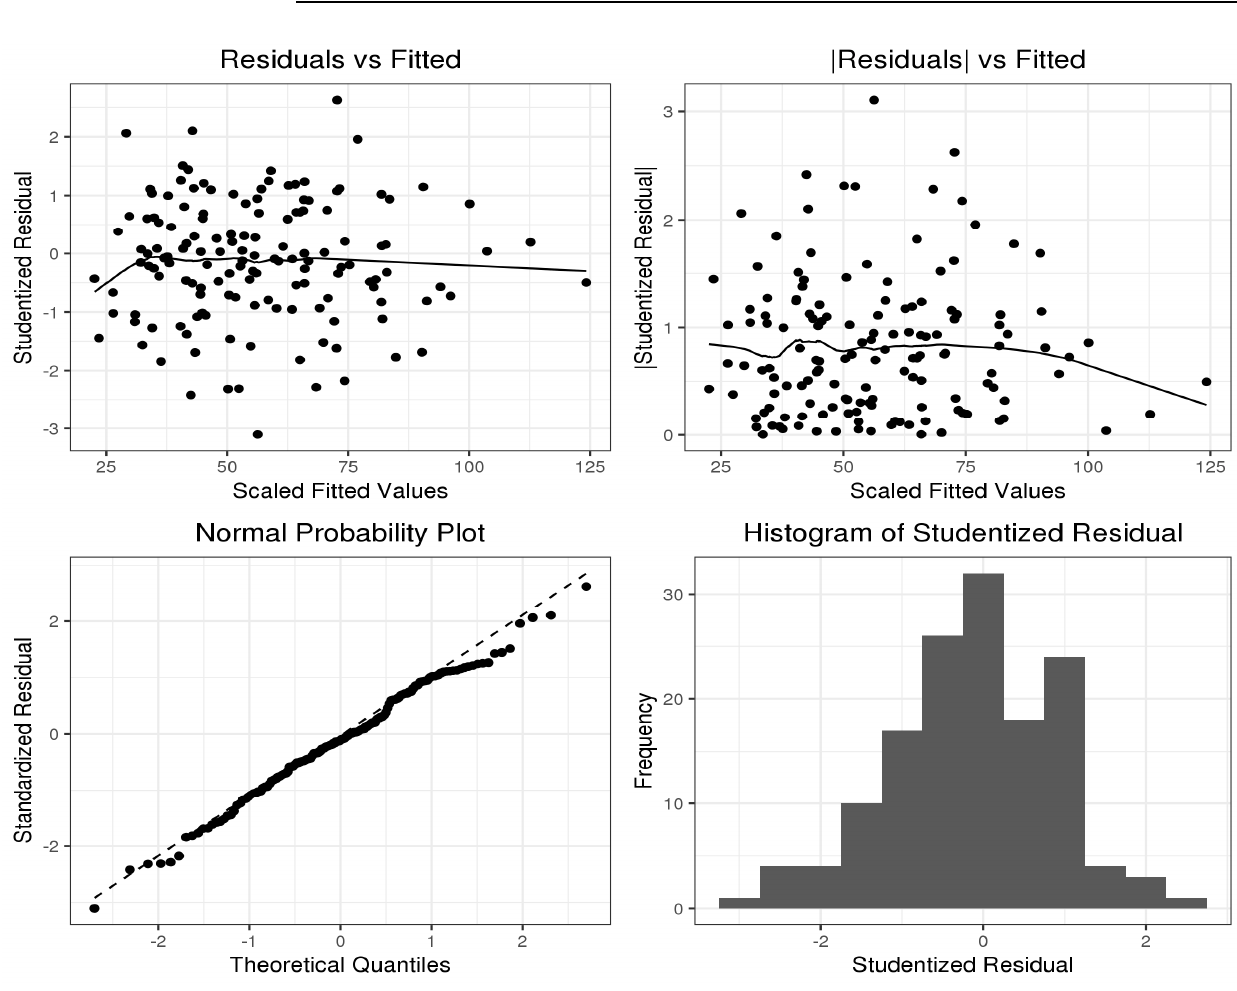
Figure 6. Plot of PM 10 Gaussian model diagnostics. Table 6. Significant variable estimates for TSP.